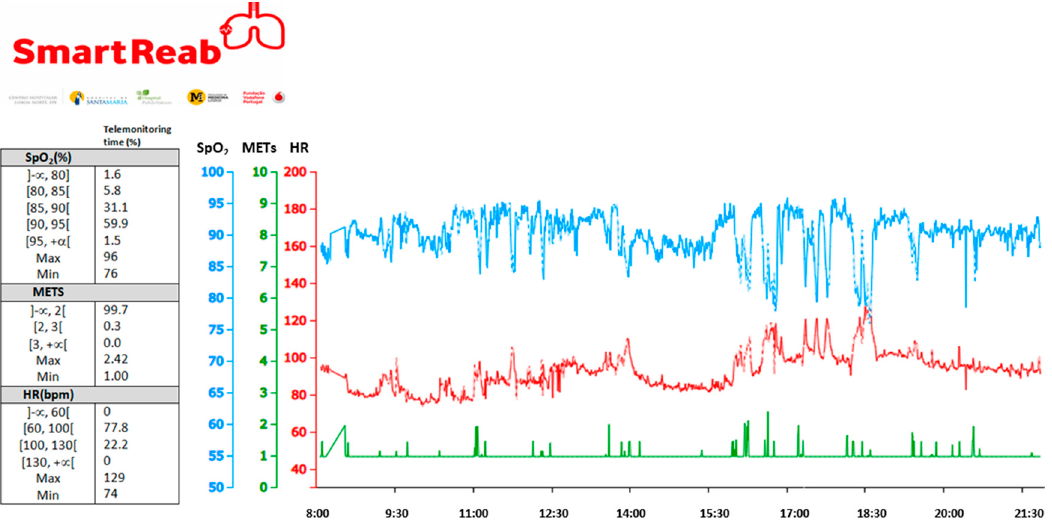
Figure 2. Example of SMARTREAB telemonitoring transcutaneous oxygen saturation (SpO 2 ), heart rate (HR) and physical activity intensity (MET) on a single daytime period of a chronic respiratory patient. This example shows 38.5% of telemonitoring time with oxygen desaturation with daily physical activity below 2.42 METs. The increased heart rate and decreased SpO 2 between 15:30 and 18:30 corresponds to performing household chores such as vacuuming, mopping, dusting and tidying up.